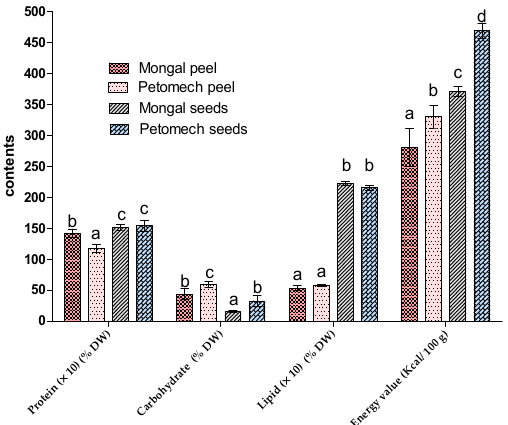
Figure 2. Biochemical composition of F1 Mongal and Petomech seeds and peels. The letters “a, b, c, d” indicate the different variations. Sticks with the same letters have statistically not different values. However, sticks with different letters have statistically different values.